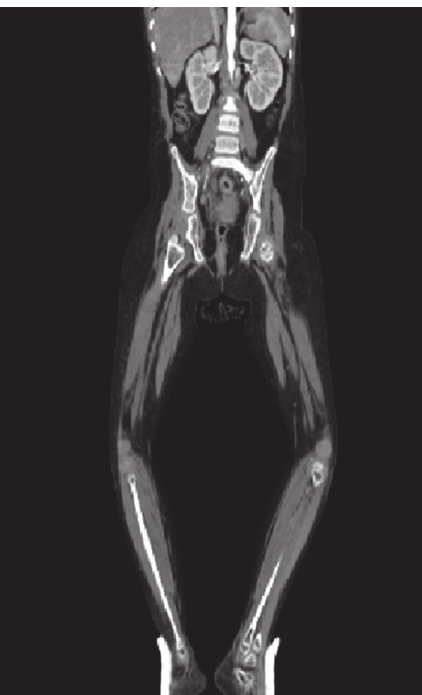
Figure 3: No contrast visible in distal popliteal and tibial arteries (no blood flow).